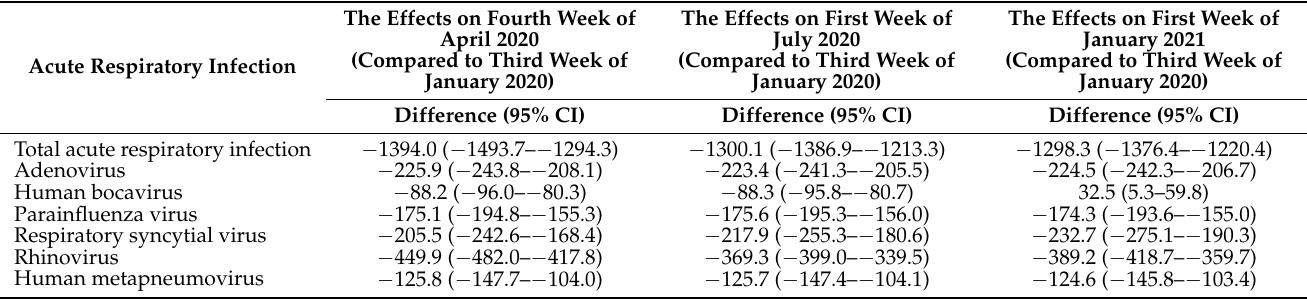
distancing policy on the number of inpatients with acute respiratory infection.